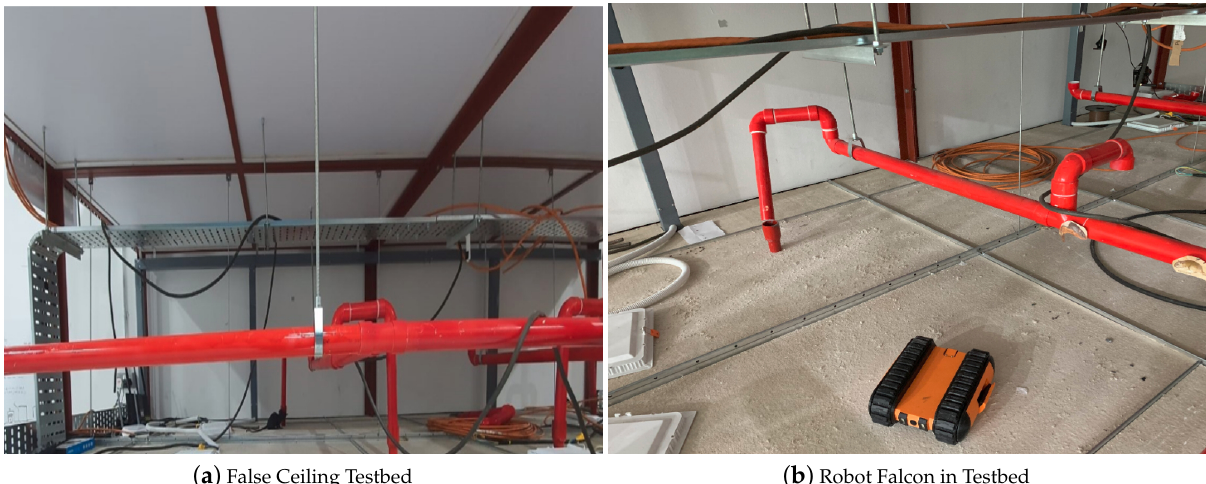
Figure 9. Falcon and the false ceiling testbed